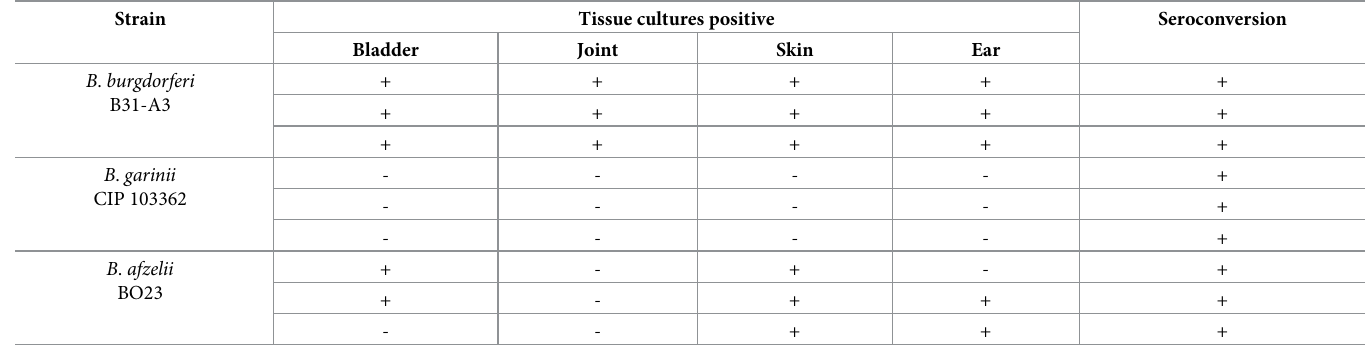
Table 3. Mouse infectivity results of B . burgdorferi , B . garinii and B . afzelii strains.